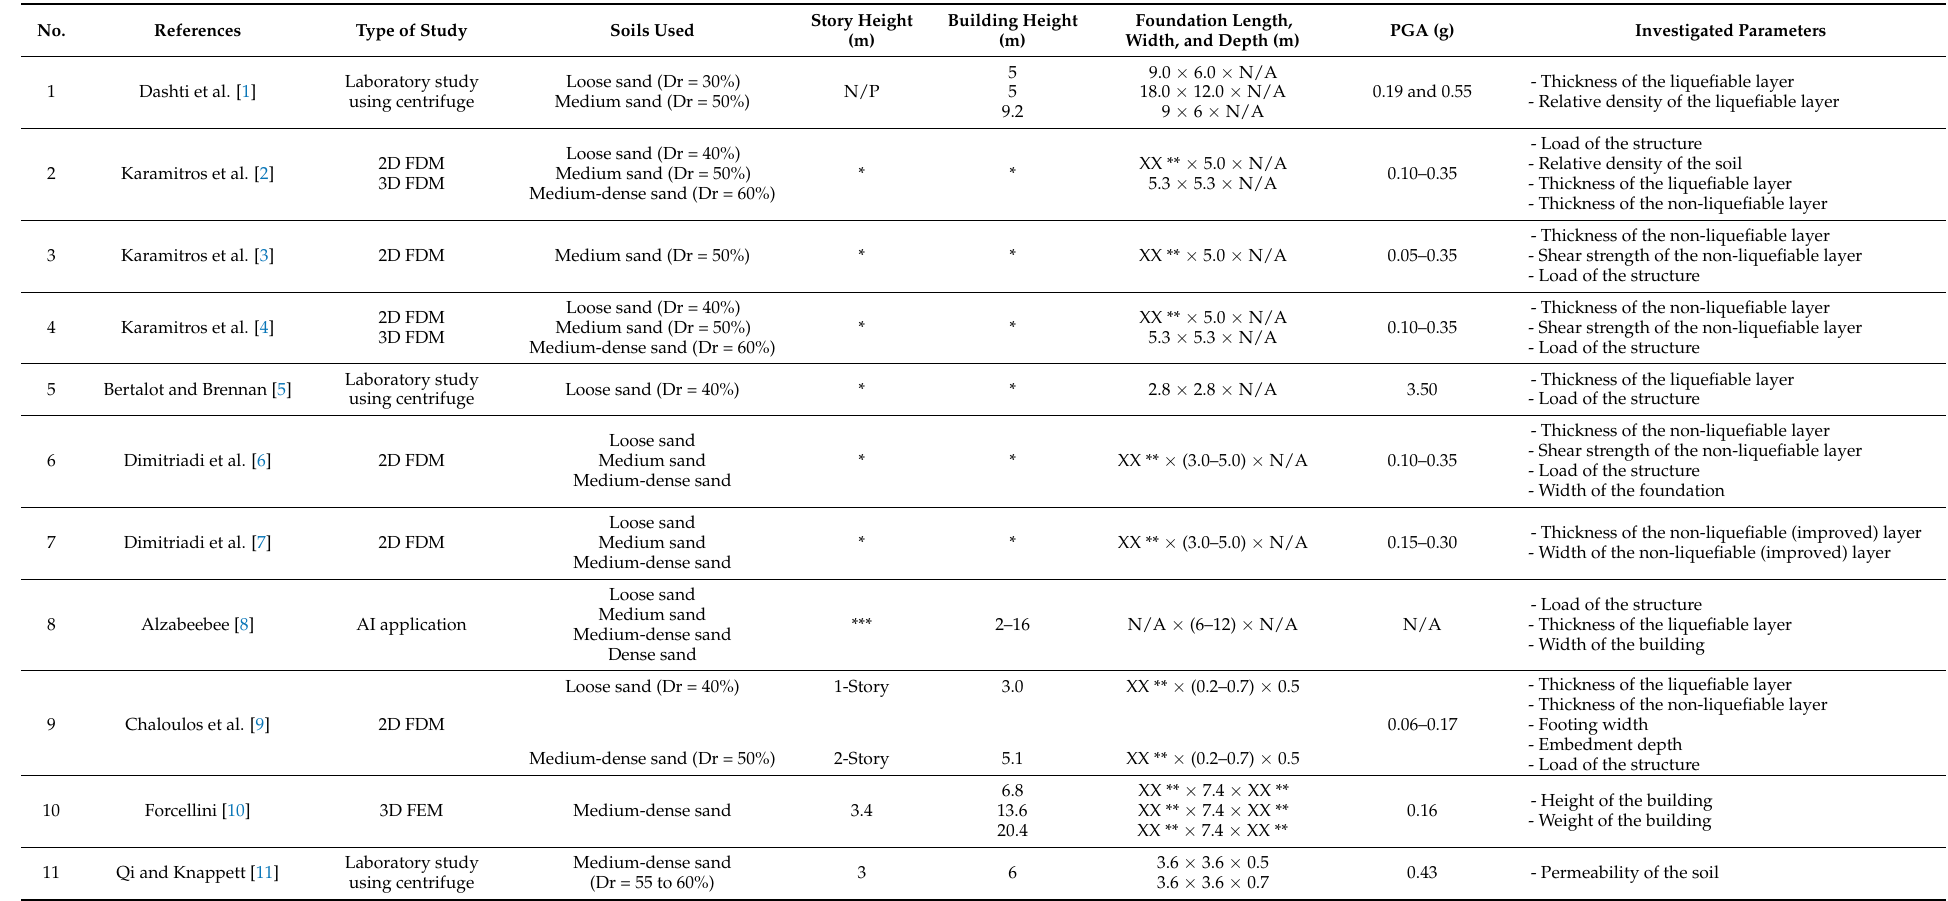
Table 1. Summary of previous studies on buildings subjected to